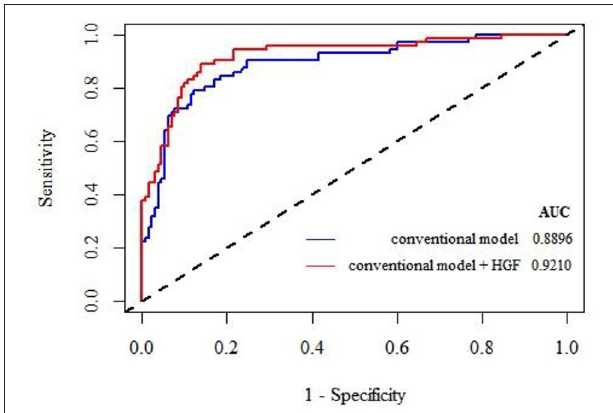
FIGURE 1 | The ROC curves of the two models are drawn to calculate the corresponding AUC value. It can be seen that the AUC value of the traditional model is 0.8896. When HGF is introduced into the model, the AUC value can reach 0.9210, with an increase of 3.1 percentage points.